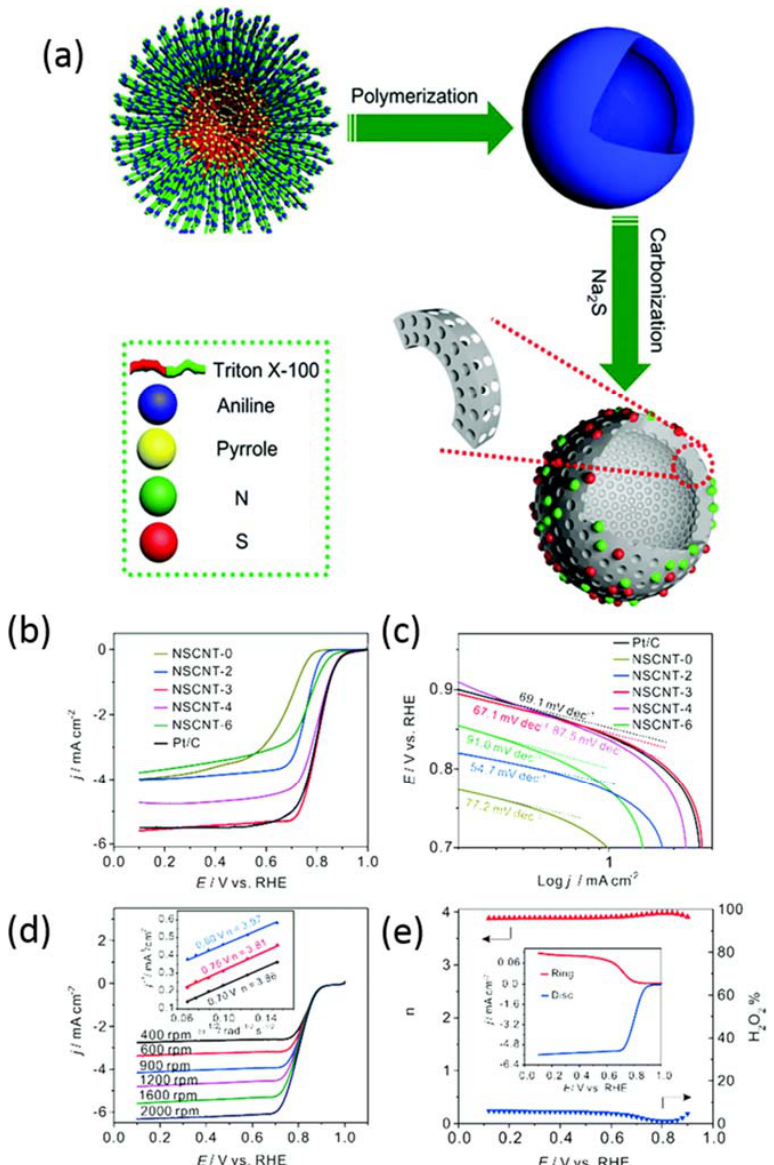
Figure 6. ( a ) Schematic illustration of the synthesis of N,S-hcs [96]. Copyright 2016, Royal Society of Chemistry. LSVs of NSCNT and Pt/C ( b ) and corresponding Tafel slopes ( c ) in 0.1 M KOH solution. ( d ) LSVs of NSCNT-3 in different rotating speeds and its corresponding Koutecky–Levich value at different potentials. ( e ) The electron transfer number n, H 2 O 2 yield, and RRDE voltammograms of